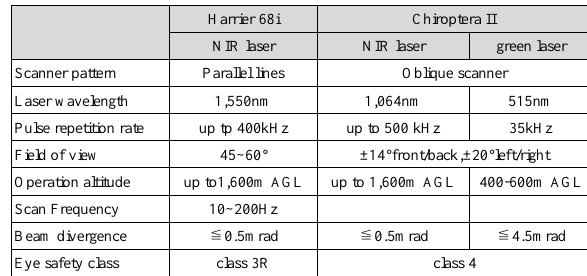
Figure 3. LiDAR sensor of Harrier 68i (left) and Chiroptera II (right)